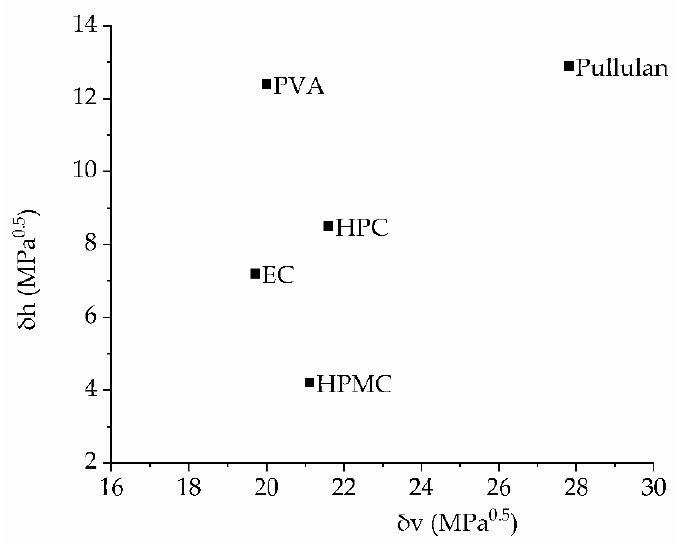
Figure 7. Bagley diagram [32] for the five polymers used for the preparation of tandem films.